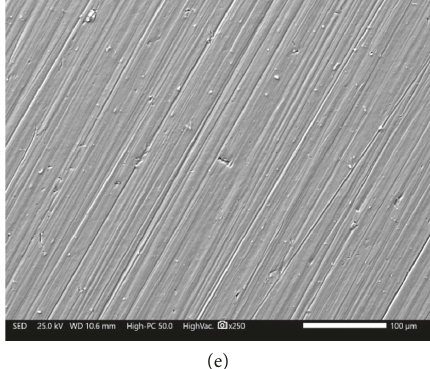
Figure 11: Morphological aspects of Ti6Al4V biomaterials after the corrosion test in 0.9% NaCl solution at 37 ° C for 100hours: (a) Ti6Al4V USA; (b) Ti6Al4V Germany; (c) Ti6Al4V China; (d) Ti6Al4V Brazil; (e) Ti6Al4V